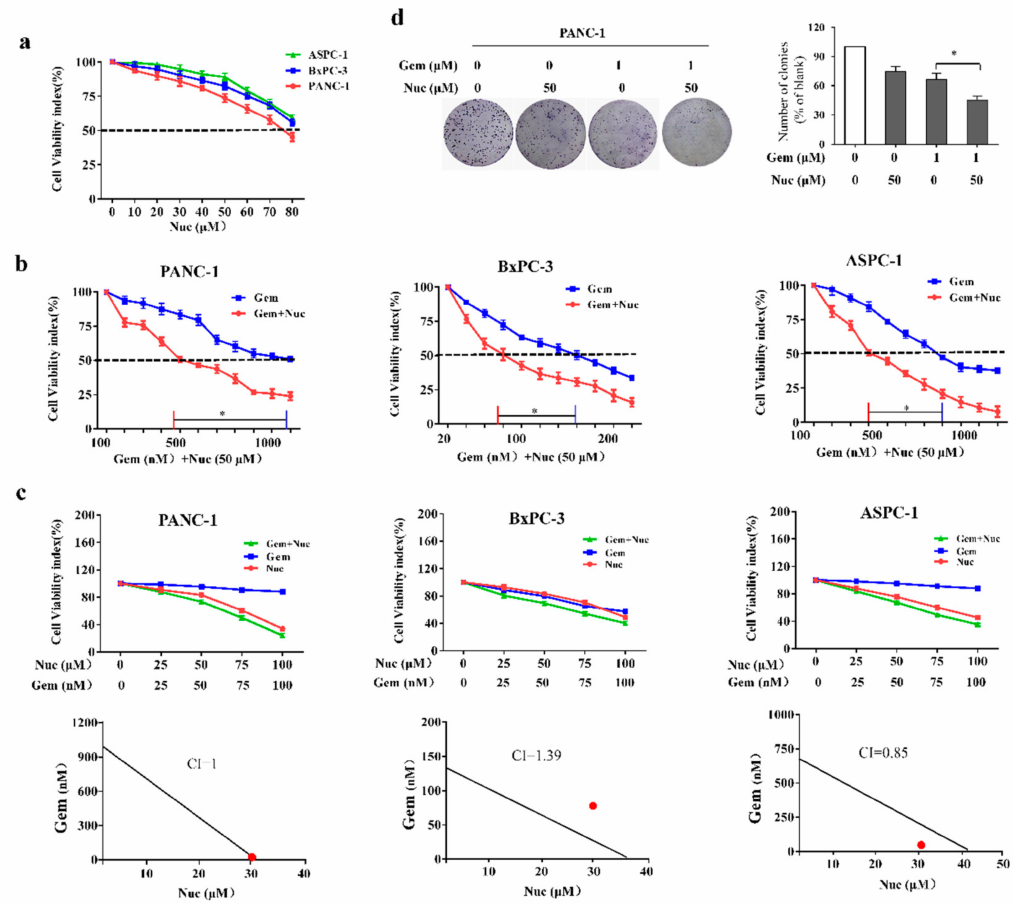
Figure 1. Nuciferine sensitizes pancreatic cancer cells to gemcitabine. ( a ) E ff ects of nuciferine on the proliferation of PANC-1, BxPC-3 and ASPC-1 cells. ( b ) Viability of three pancreatic cancer cell lines treated with di ff erent concentrations of gemcitabine in the absence or presence of nuciferine (50 µ M) for 72 h. ( c ) Drug interaction between nuciferine and gemcitabine was assessed using the combination index (CI). ( d ) Clonogenicity of PANC-1 cells following treatment with nuciferine and / or gemcitabine for 24 h. Nuc, nuciferine; Gem, gemcitabine. * p <